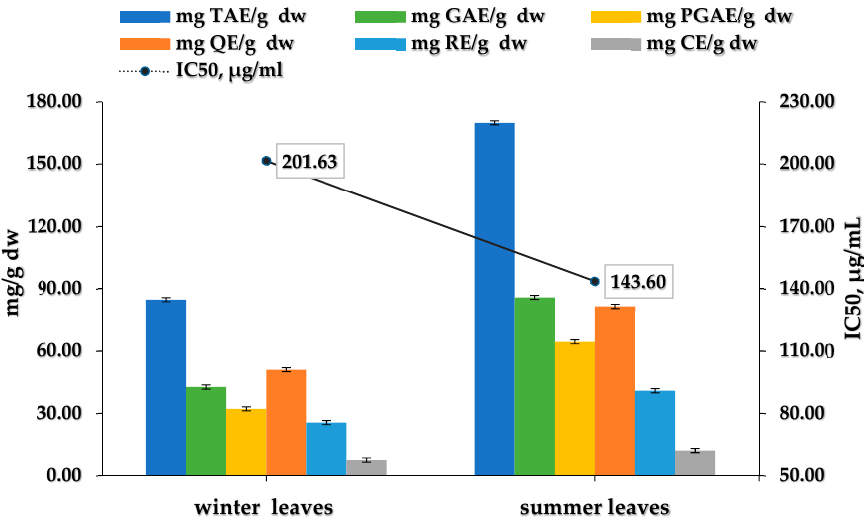
Figure 5. Evaluation of the TPC, TFC, and IC 50 of the Cistus incanus summer and winter